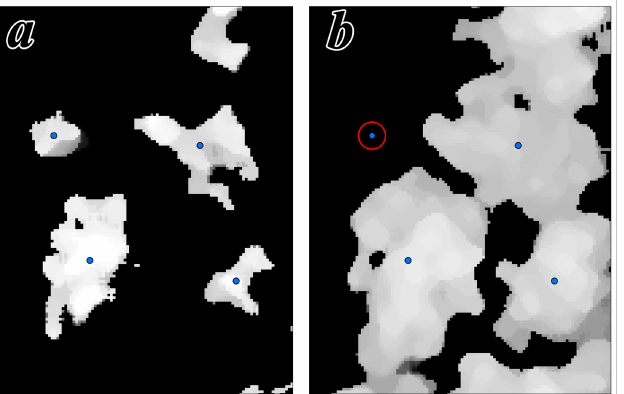
Figure 5. Example of the initial seed point in the data view from leaf-off ( a ) and leaf-on ( b ) seasons (the seed point in the red circle was removed by the re-screening